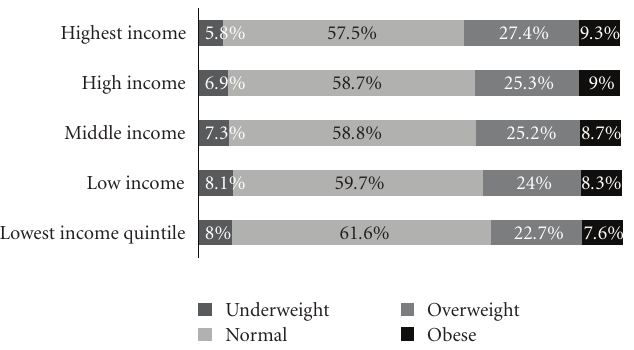
Figure 1: Prevalence of BMI classification by income quintile, WHS, 2002-2003.